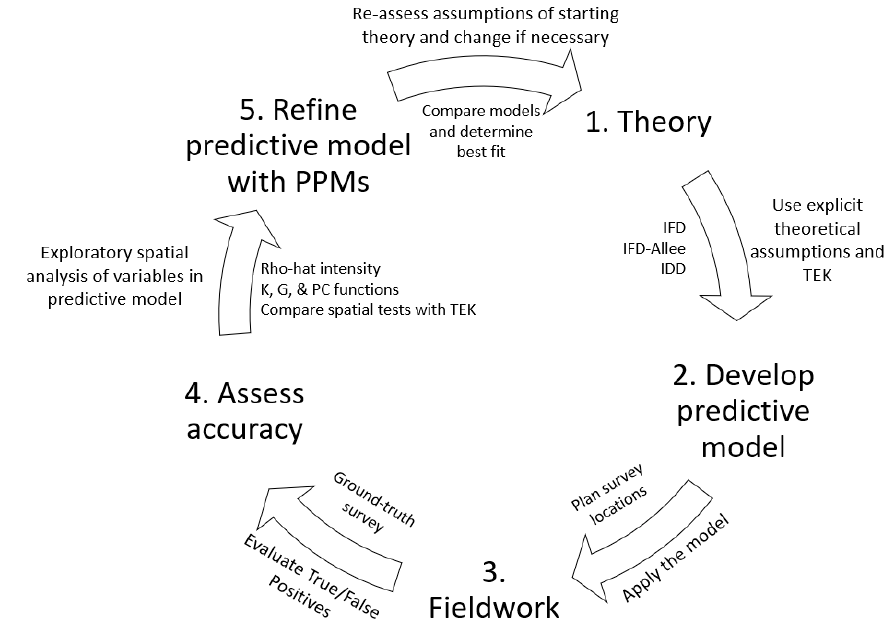
Figure 2. Illustration of iterative modeling process. This method permits for simultaneous and constant re-evaluation of the current predictive model and interpretation of the archaeological record.